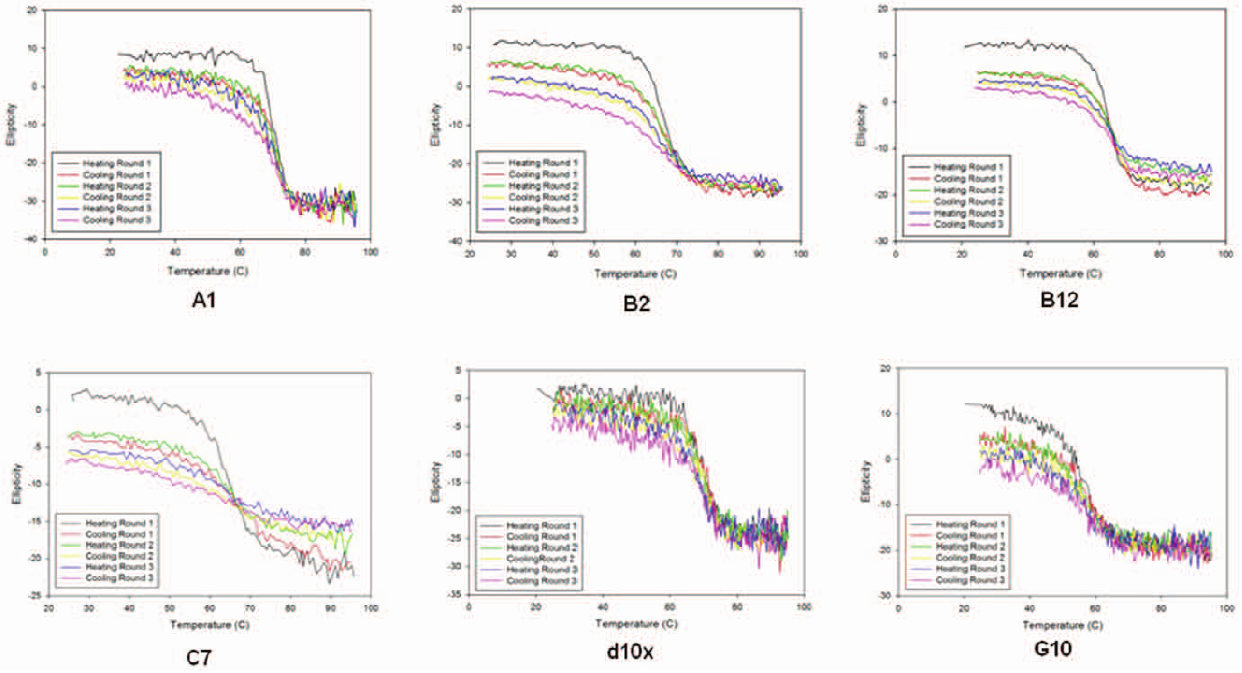
Figure 6. Determination of melting temperature and thermal stability of sdAbs. The ellipticity of polarized light at 205 nm was measured over a temperature range (25–95 u C) to determine the melting temperature of each sdAb and its ability to refold folding thermal denaturation.